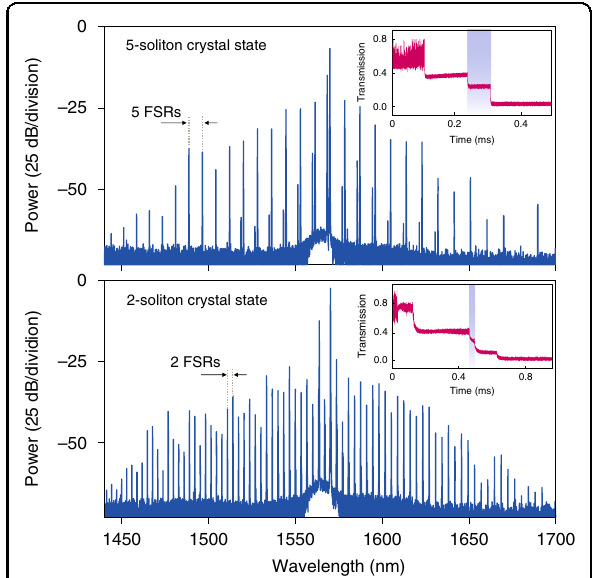
Fig. 4 Optical spectra of the soliton crystal states. The insets show the transmission traces of the comb power, the marked region is the corresponding soliton state when the pump laser is adjusted to this stage. Top, 5-soliton crystal state; Bottom, 2-soliton crystal